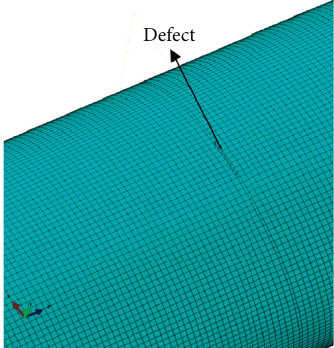
Figure 5: Mesh distribution at the